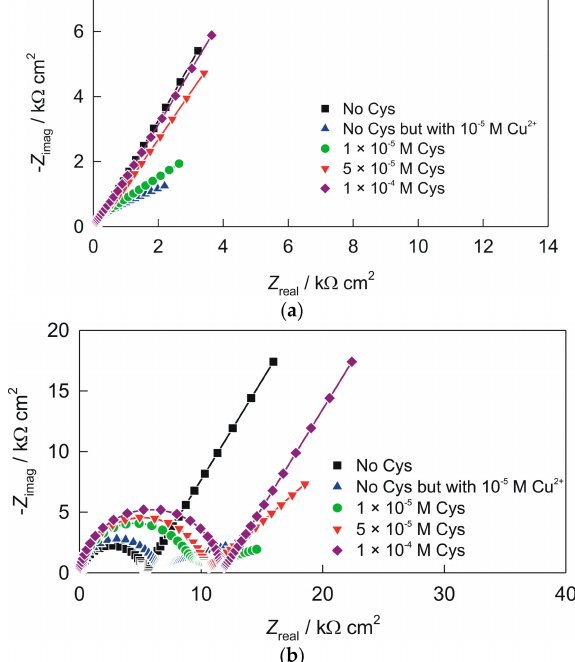
Figure 3. Nyquist plots recorded in 90 mL 0.1 KNO 3 + 10 mL 0.1 M acetate buffer (pH 5), without and with the presence of the various cysteine concentration (by successive addition of cysteine in the solutions that were spiked with 1 × 10 − 5 M Cu 2+ ): ( a ) electrode “ACS”; ( b ) electrode “AC1.8S”. Frequency range: 100 kHz–0.05